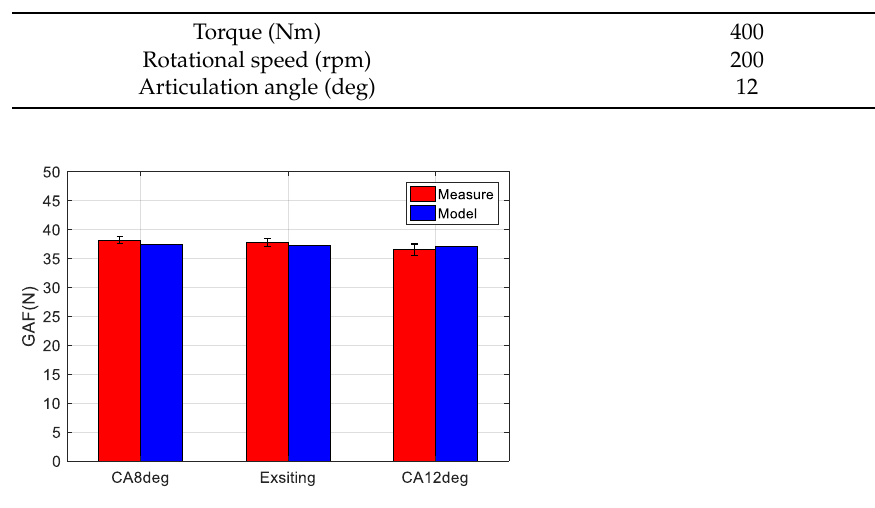
Figure 13. GAF verification results with respect to contact angle.